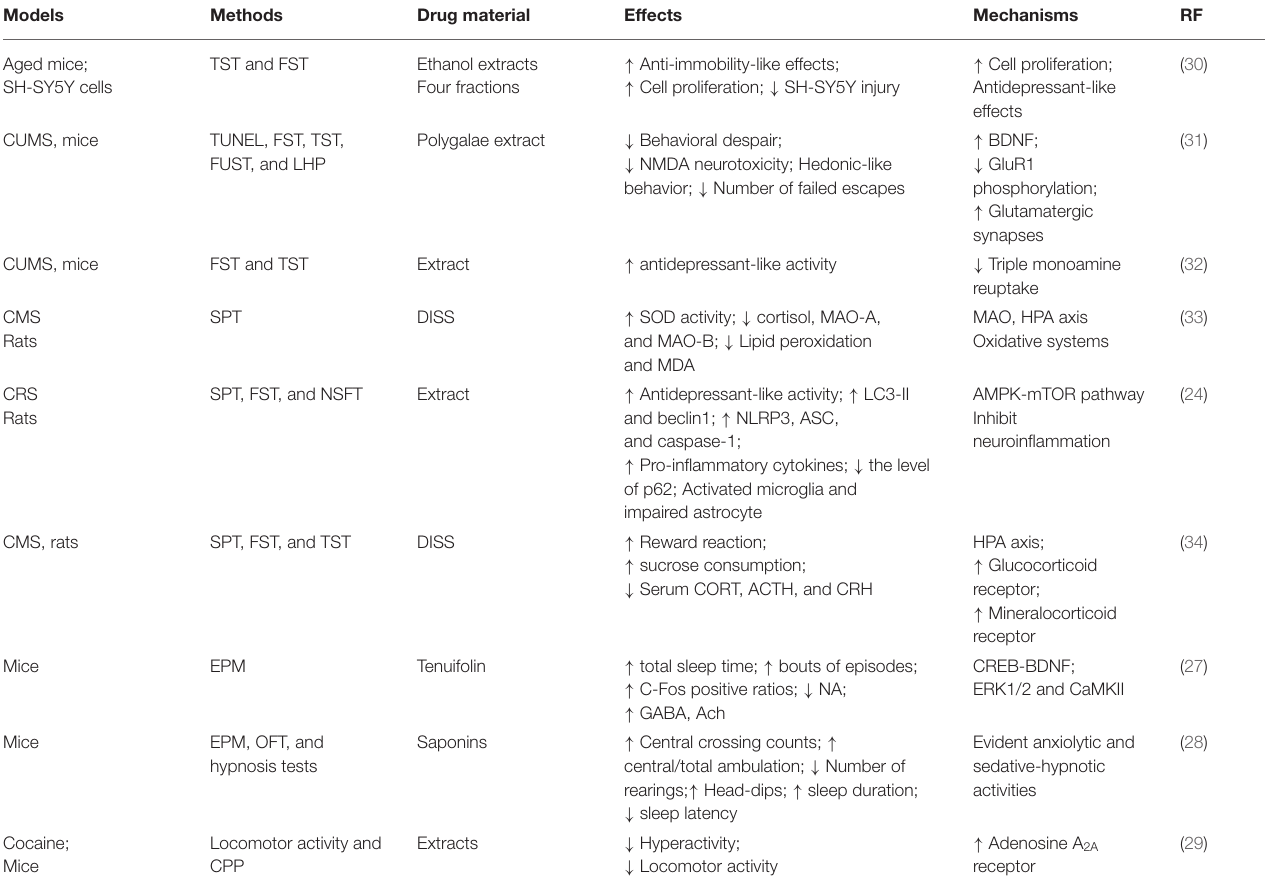
TABLE 1 | Summarized anxiolytic and antidepressant effects of RP in the nervous system.